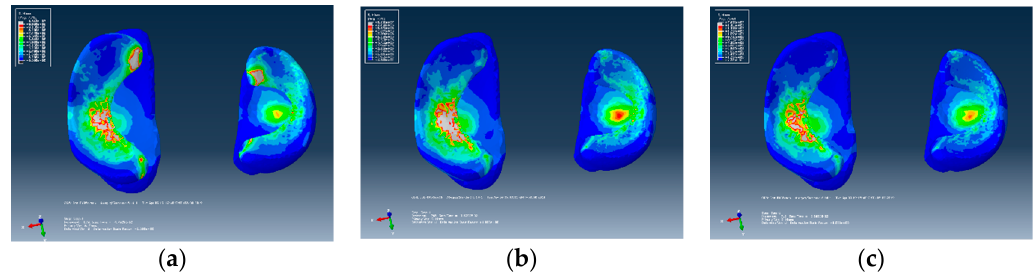
Figure 10. Stress distribution of tibial plateau and meniscus: ( a ) forward landing; ( b ) neutral landing; ( c ) backward landing.